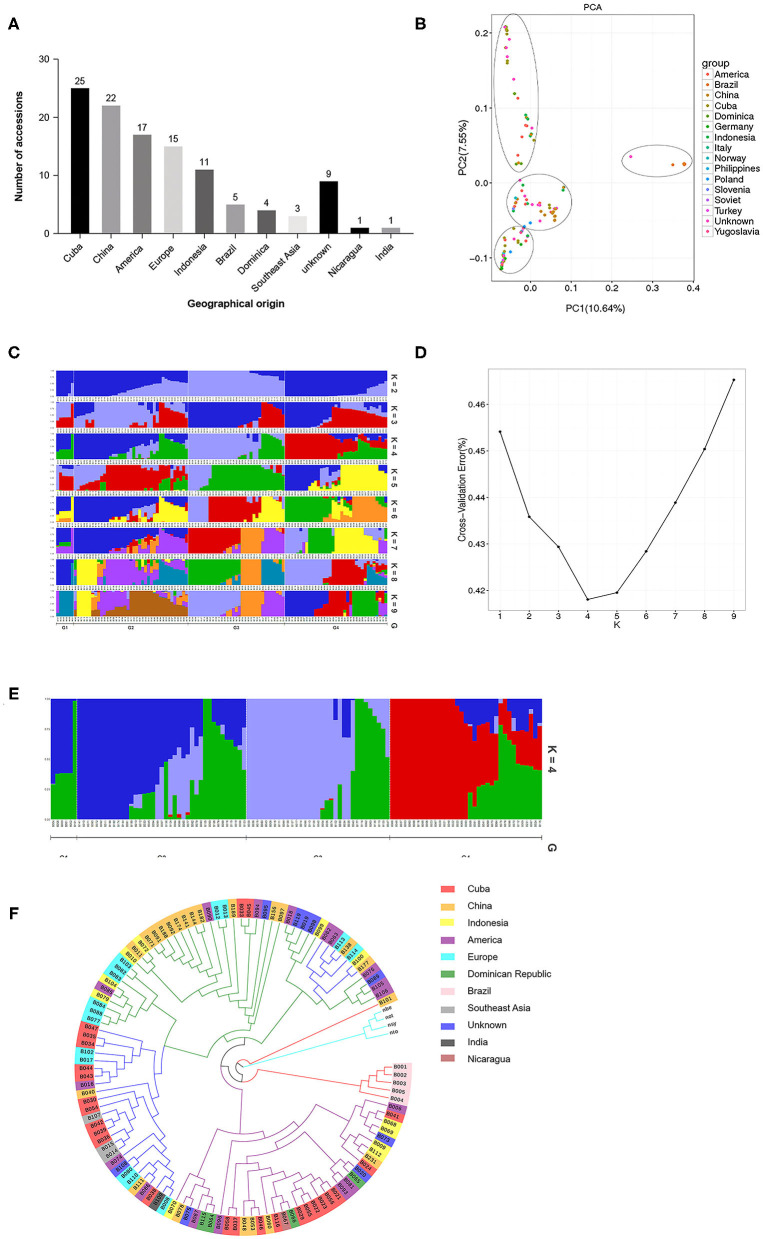
Population genetic analysis of 113 cigar tobacco accessions based on polymorphic SNP loci. (A) Geographical origins of the 113 cigar tobacco accessions used in this study. (B) Principal component analysis (PCA). (C) Population structure of the 113 cigar tobacco germplasm resources at different values of K. (D) Cross-validation error rates corresponding to different K values. (E) Population structure of the 113 cigar tobacco germplasm resources at K = 4. (F) An unrooted neighbor-joining (NJ) phylogenetic tree.